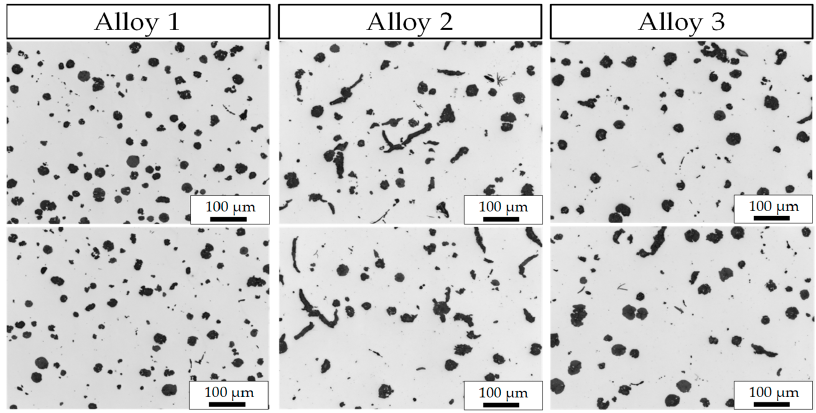
Figure 7. Exemplary micrographs of alloys A1–A3 at 100× magnification.